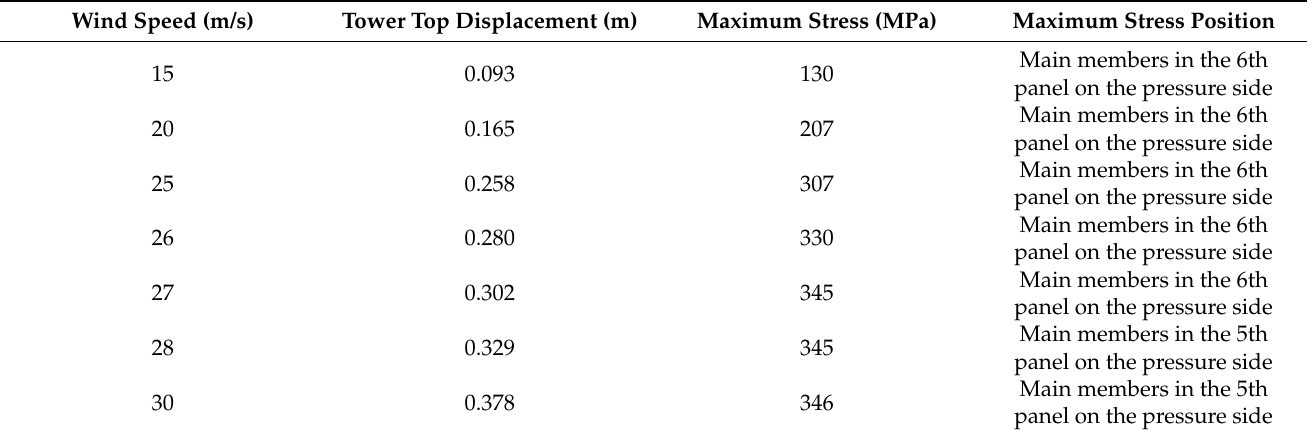
Table 5. Calculation results of displacement and internal force of transmission tower at differ- ent